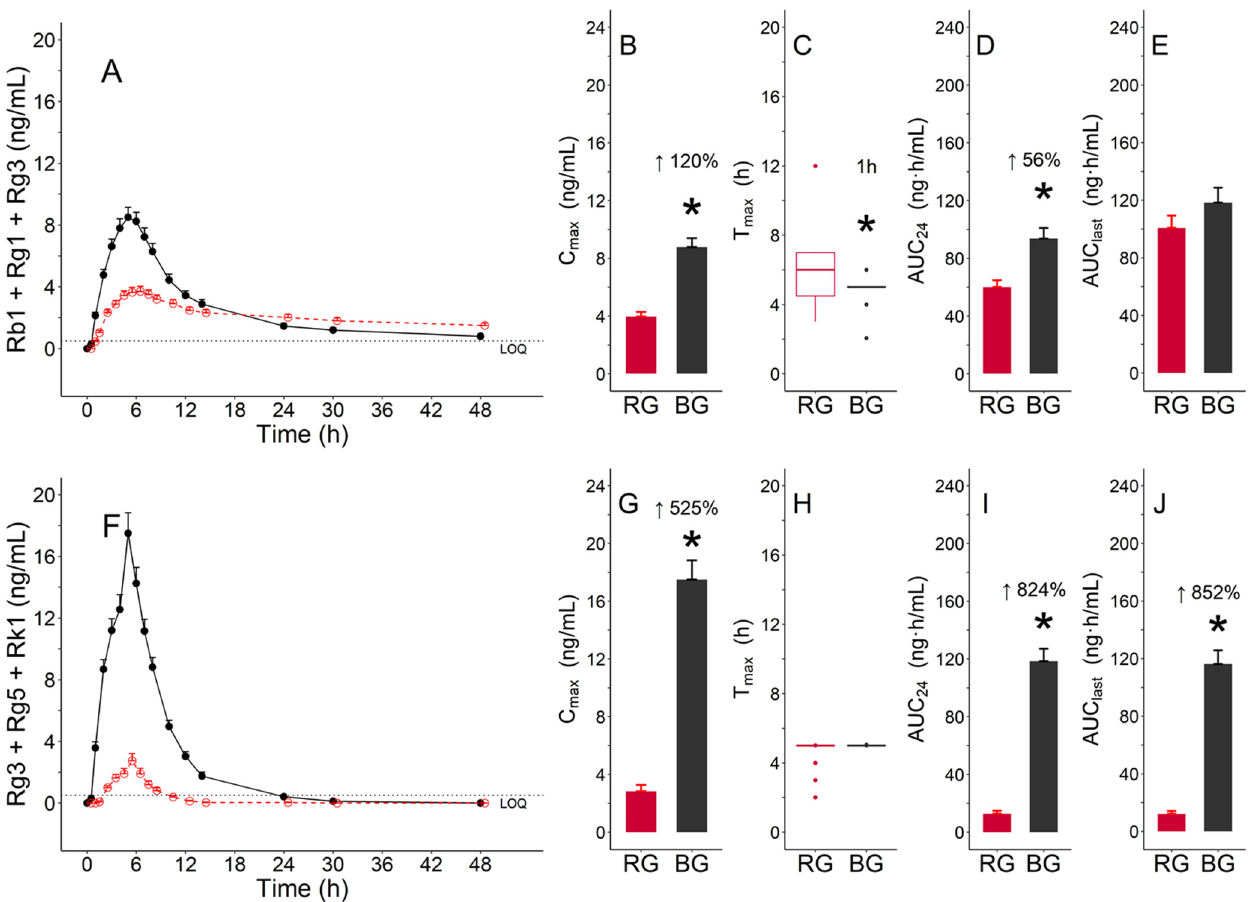
Figure 5. Pharmacokinetic characteristics of functional ginsenoside groups after the administration of a single dose of red ginseng (RG) (red color) and black ginseng (BG) (black color) extracts: ( A – E ) Functional ginsenoside group with Rb1, Rg1 and Rg3; ( F – J ) functional ginsenoside group with Rg3, Rg5, and Rk1; ( A , F ) mean ( ± standard error (SE)) plasma concentration–time profile of group 1; ( B , G ) mean ( ± SE) for C max ; ( C , H ) median (inter-quartile range (IQR)) boxes for T max (lines for 1.5 times the IQR and dots for outliers); ( D , I ) mean ( ± SE) for area under the concentration–time curve AUC from 0 to 24 h (AUC 24 ); ( E , J ) mean ( ± SE) for AUC from 0 to the actual time point relevant to the last concentration above the lower limit of quantification (LLOQ) (AUC last ). * Statistically significant at p < 0.05.